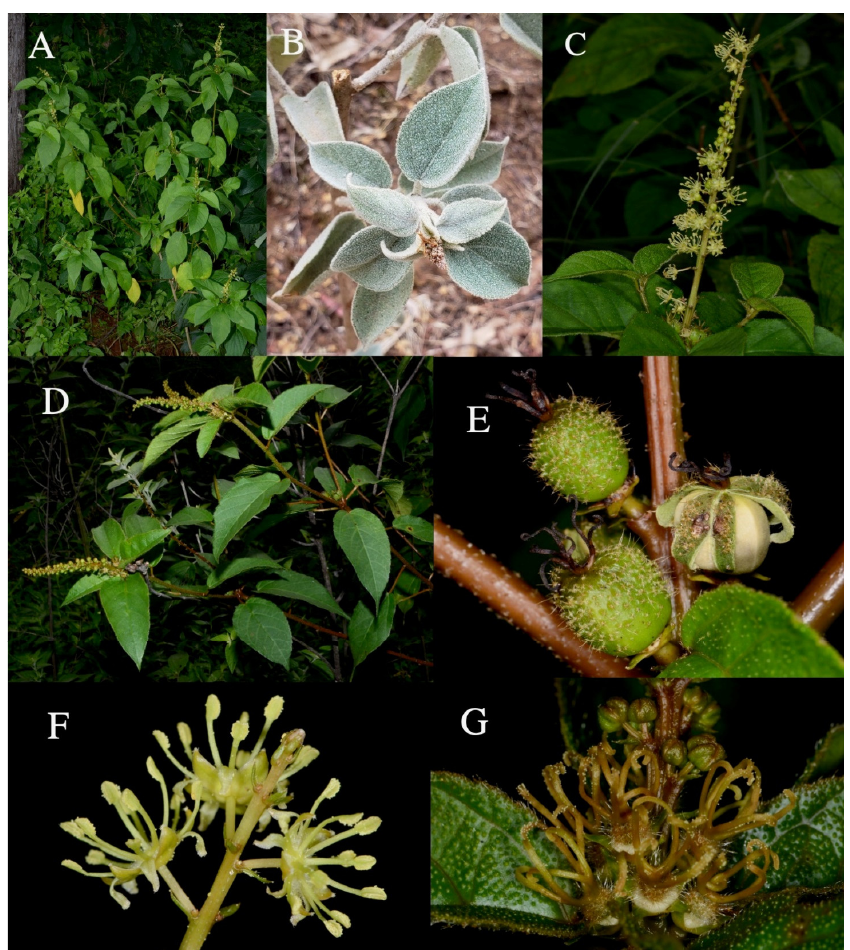
Figure A1. Croton adspersus. ( A ) Habit. ( B ) Dry season leaves and young inflorescence. ( C ) Inflorescence. ( D ) Flowering branches. ( E ) Fruits. ( F ) Staminate flowers. ( G ) Pistillate flowers. B photographed by Ignacio Torres and used with